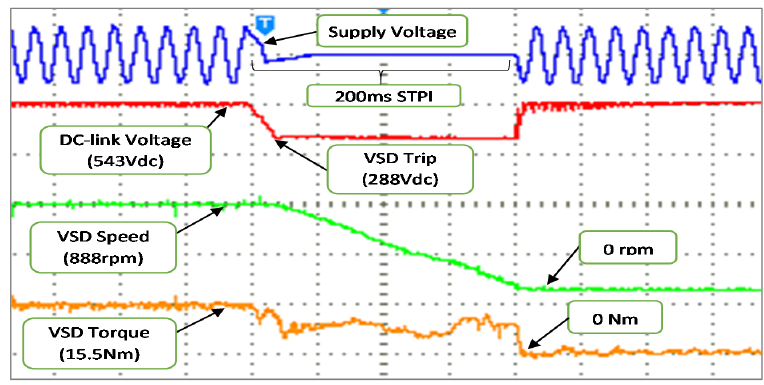
Figure 13. Experimental results without dc-link voltage compensation.